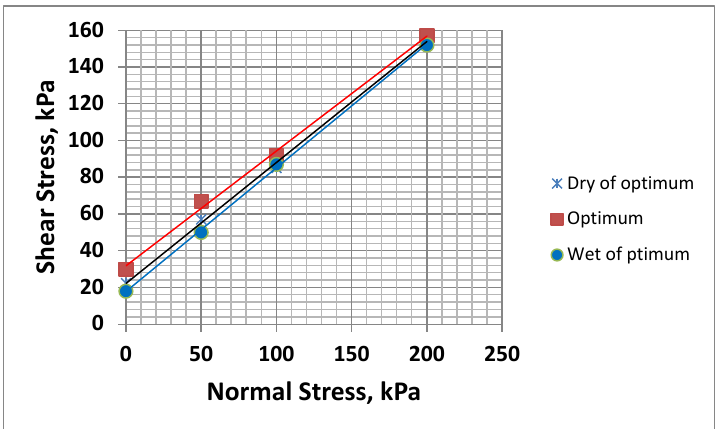
Figure 12. Normal stress vs. shear stress for mixture with compacted 10% bentonite under three different moisture conditions .